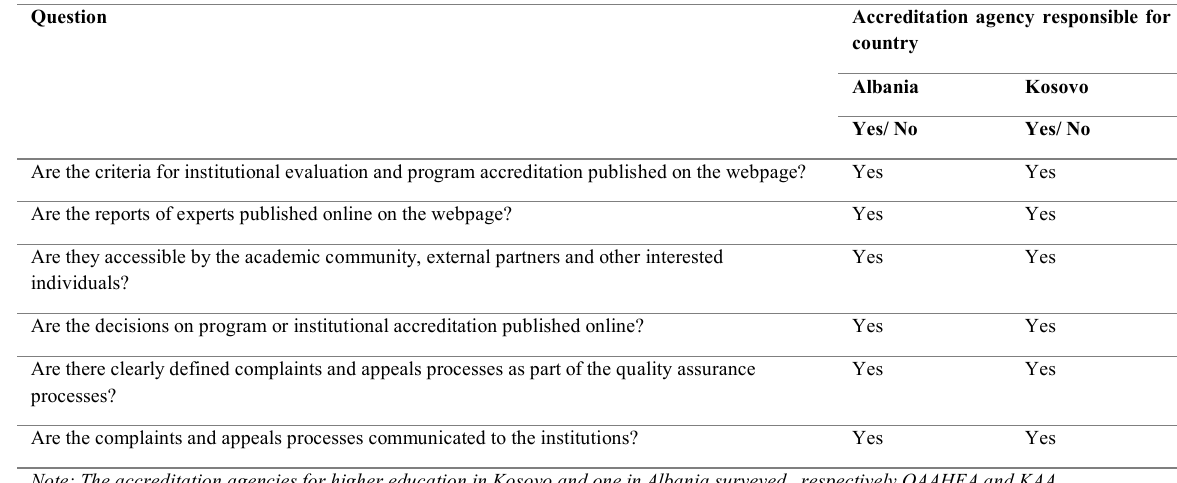
Table 19 : External quality assurance: Criteria’s for transparency, outcomes, reporting, complaints and appeals (KAA and QAAHE) Question Accreditation agency responsible for